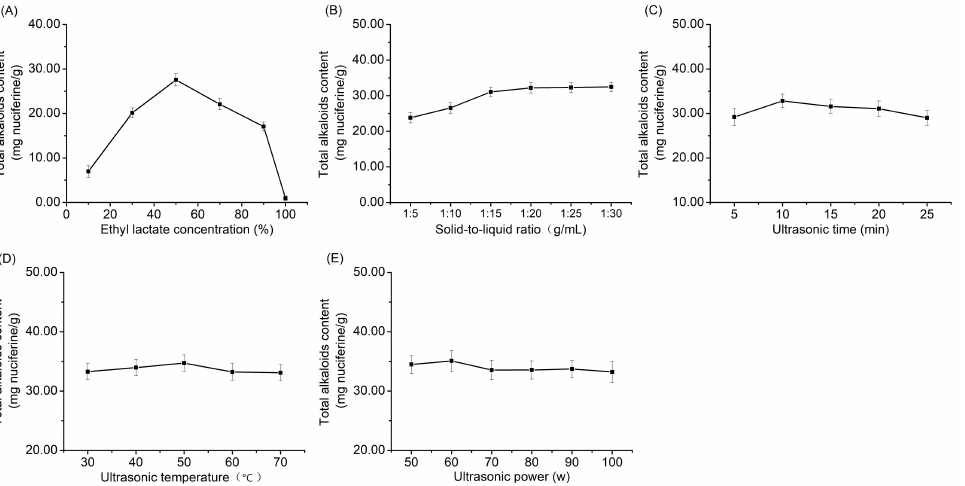
Figure 1. Effects of ( A ) ethyl lactate concentration, ( B ) solid-to-liquid ratio, ( C ) ultrasonic time, ( D ) ultrasonic temperature and ( E ) ultrasonic power on the total alkaloid content extracted from lotus seed